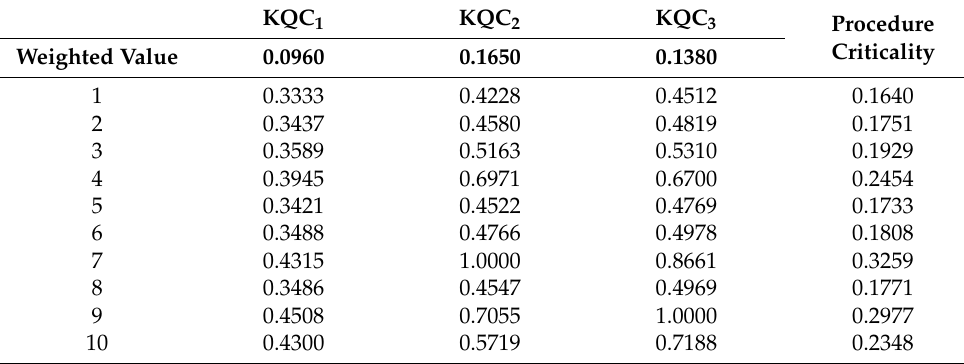
Table 4. Calculation result table of procedure